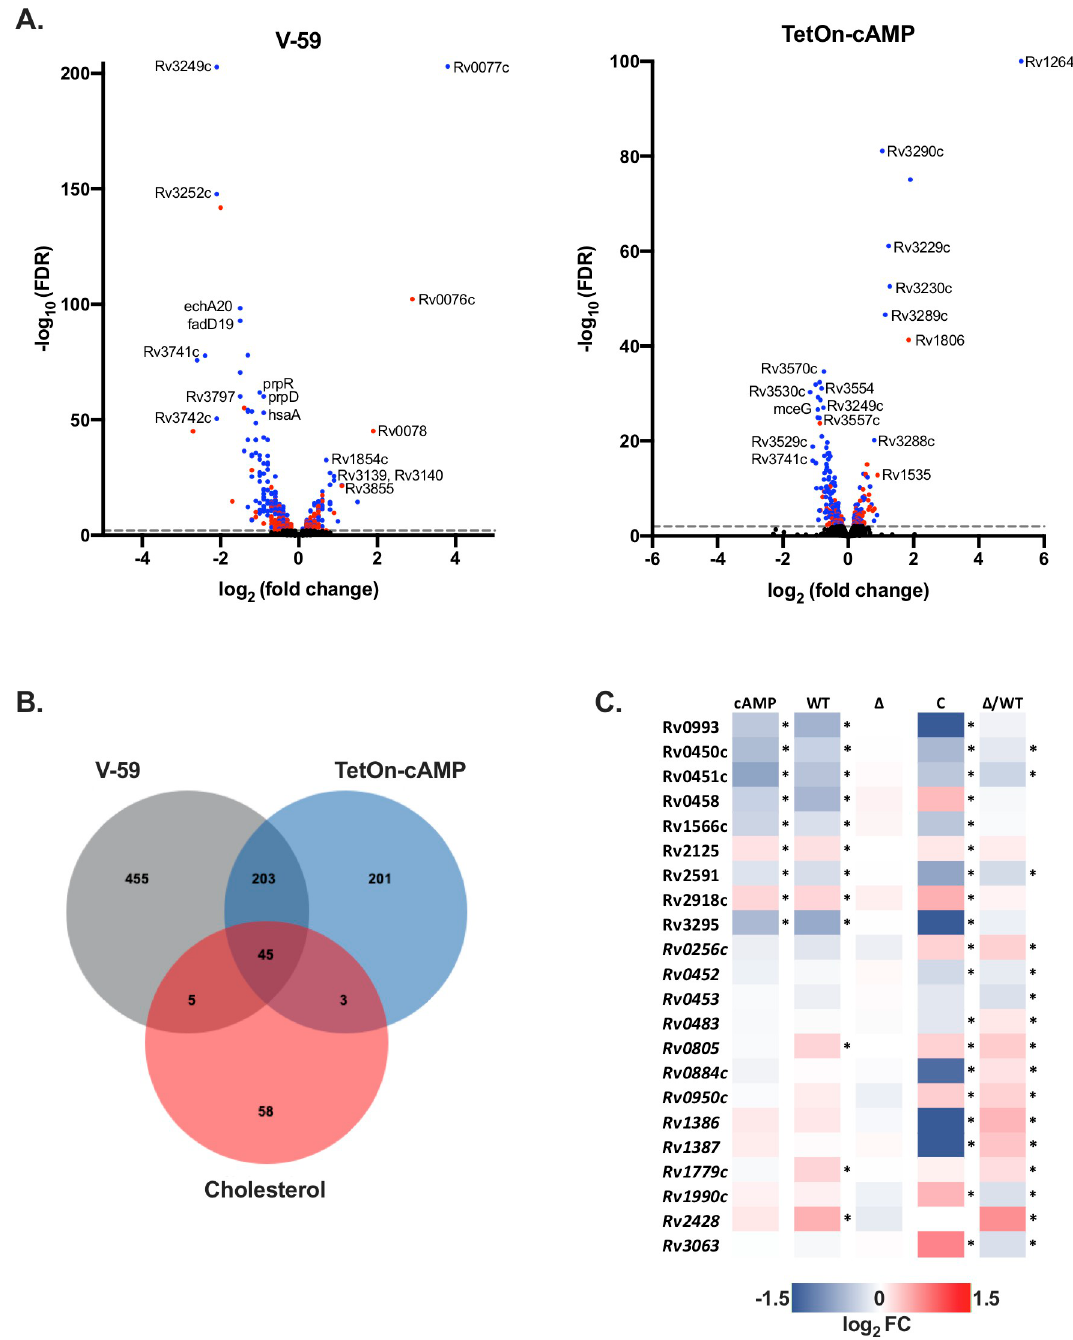
Fig 8. V-59 treatment and induction of TetOn-cAMP are associated with transcriptional changes in select CRP Mt regulon genes. ( A ) Volcano plots displaying differentially expressed genes following V-59 treatment of WT Mtb relative to DMSO control (left), or following Atc treatment of TetOn-cAMP Mtb relative to EtOH control (right), based on RNA-seq. Each dot represents a single gene, genes in blue are significant (FDR < 0.05) in both data sets and genes in red are unique to their respective data set. Dashed line indicates FDR cutoff < 0.01. ( B ) Venn diagram showing the number of significantly differentially expressed genes shared by the V-59 and TetOn-cAMP conditions, and how many of these belong to the KstR cholesterol-related regulon. ( C ) RNA-seq analysis quantifying differentially expressed genes from Mtb grown in cholesterol media, following V-59 treatment, or induction of TetOn- cAMP with Atc. Genes depicted are predicted members of the CRP MT regulon. Only genes with significant differential expression in both the V-59 and TetOn-cAMP conditions, or genes with intrinsic changes in the ∆ Rv1625 strain (in italics), are shown. “cAMP” = Tet-On cAMP Atc vs. EtOH, “WT” = WT V-59 vs. DMSO, “ ∆ ” = Δ Rv1625 V-59 vs. DMSO, “C” = Comp Full V-59 vs. DMSO, “ Δ /WT” = ∆ Rv1625 DMSO vs. WT